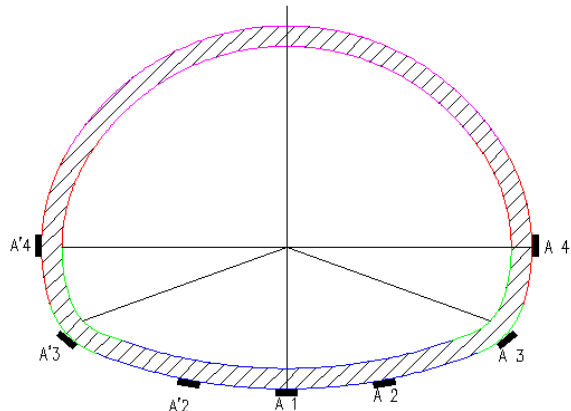
Figure 6. Location of displacement monitoring points.